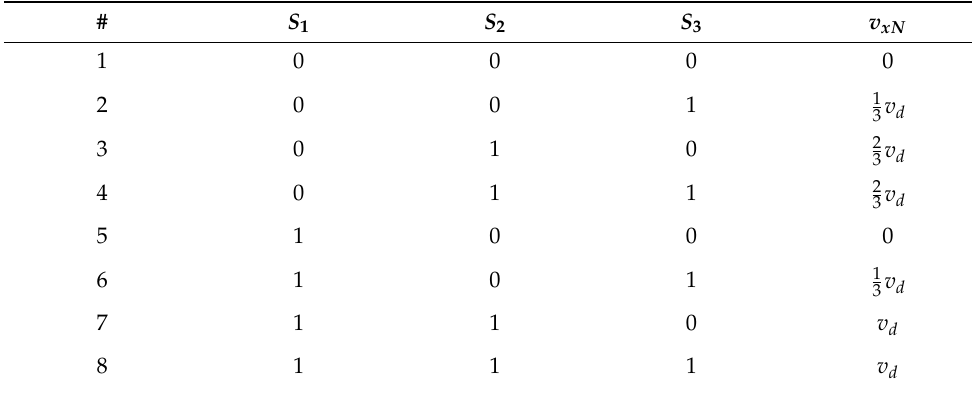
Table 1. Switching states and output voltages for the 4L-QN